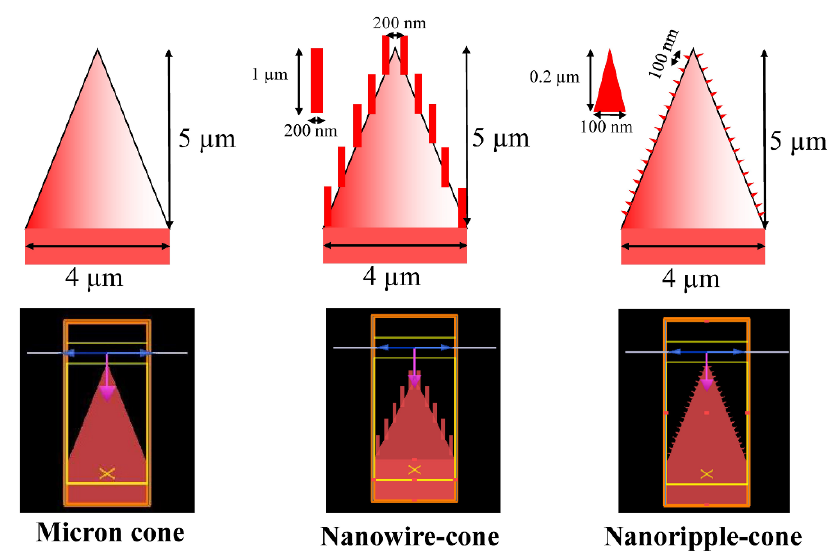
Figure 6. Modeling information and 2D models of cone alone, nanowire-cone and nanoripple- cone.